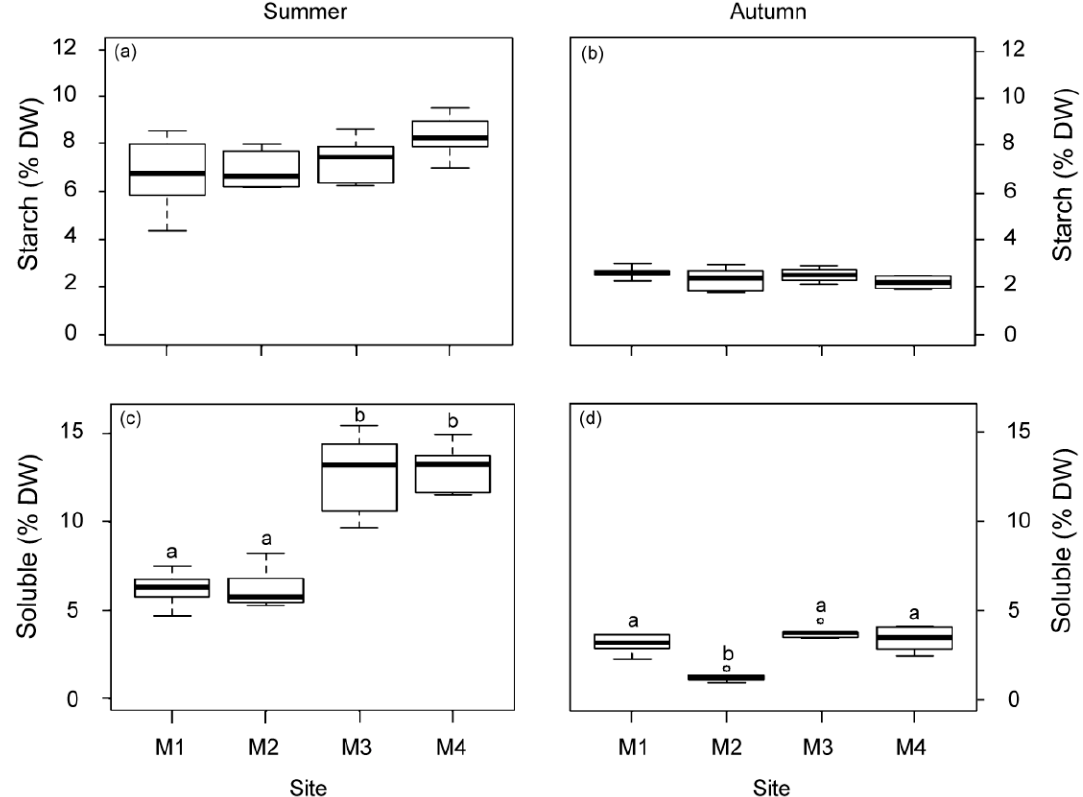
Figure 4. Non-structural carbohydrate content in rhizomes, starch ( a , b ) and soluble sugars ( c , d ) of P. oceanica plants from the four deep meadow sites (M1–M4) in summer and autumn. Different letters denote significant differences among sites (Tukey test, p <